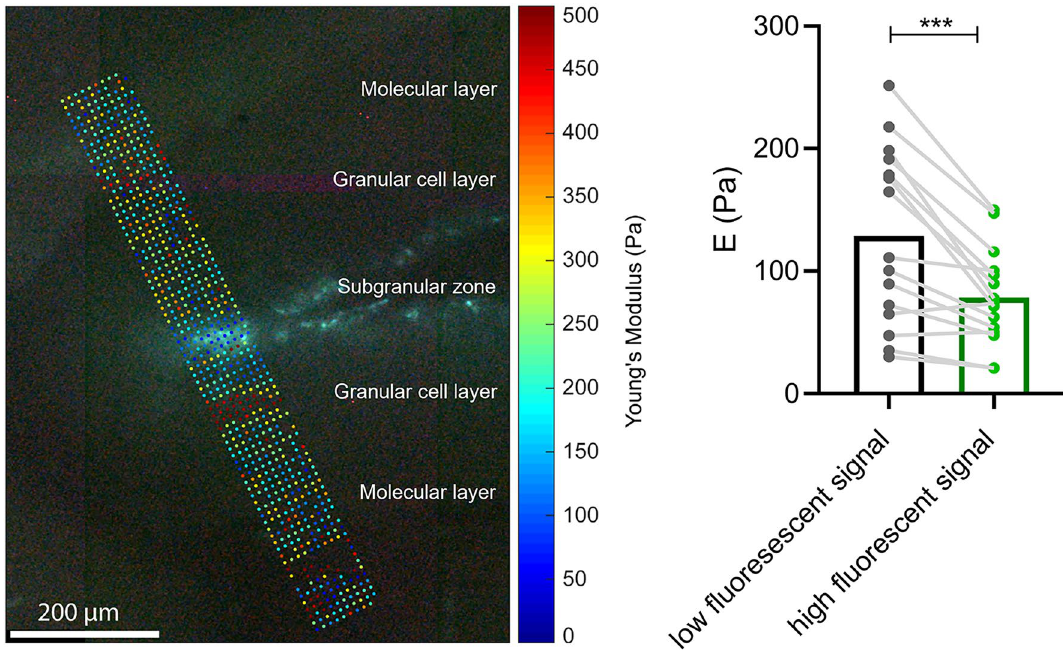
Figure 5. Ex vivo AFM results. On the left, a representative measurement profile overlaid on the high fluorescence region is shown (more data are shown in Supplementary Fig. 2). Right, the subgranular zone (area with high fluorescent signal) is significantly softer than the surrounding tissue (low fluorescent signal), n = 15, ***p = 0.0004.